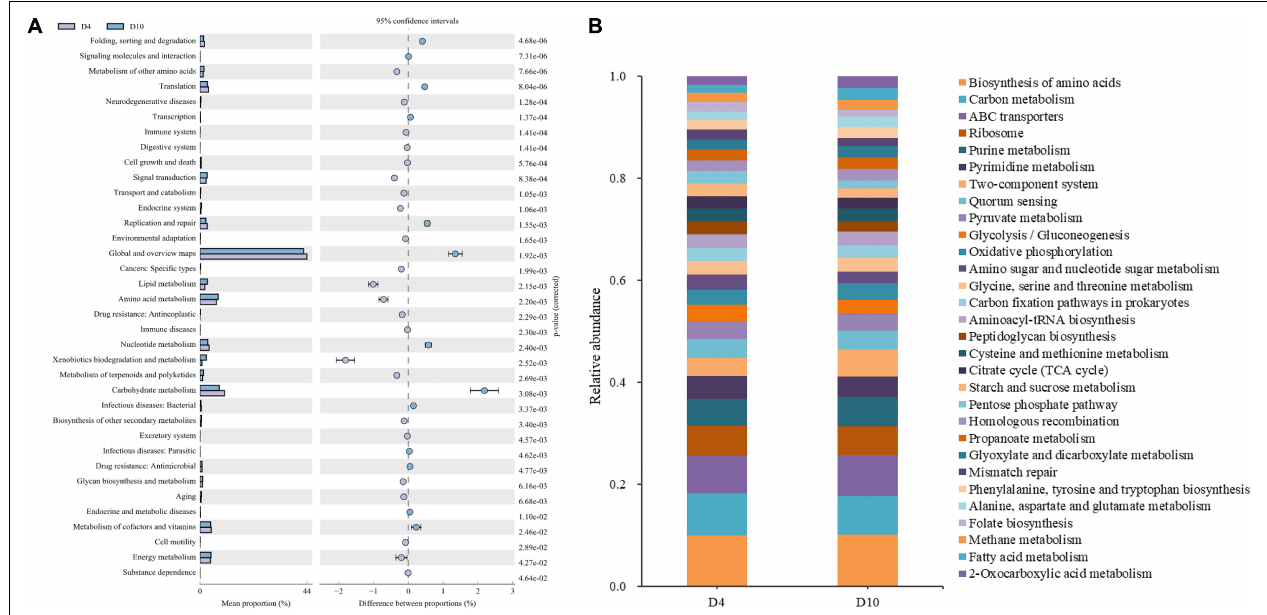
FIGURE 4 | Functional properties that are related to microbial metabolism in the samples. (A) Comparison of bacterial metabolic pathways in refrigerated (4 ◦ C) sturgeon filets between days 4 and 10. (B) Relative abundance of the bacterial three-level metabolic pathways in the top 30. Metabolic inference based on the 16S rRNA